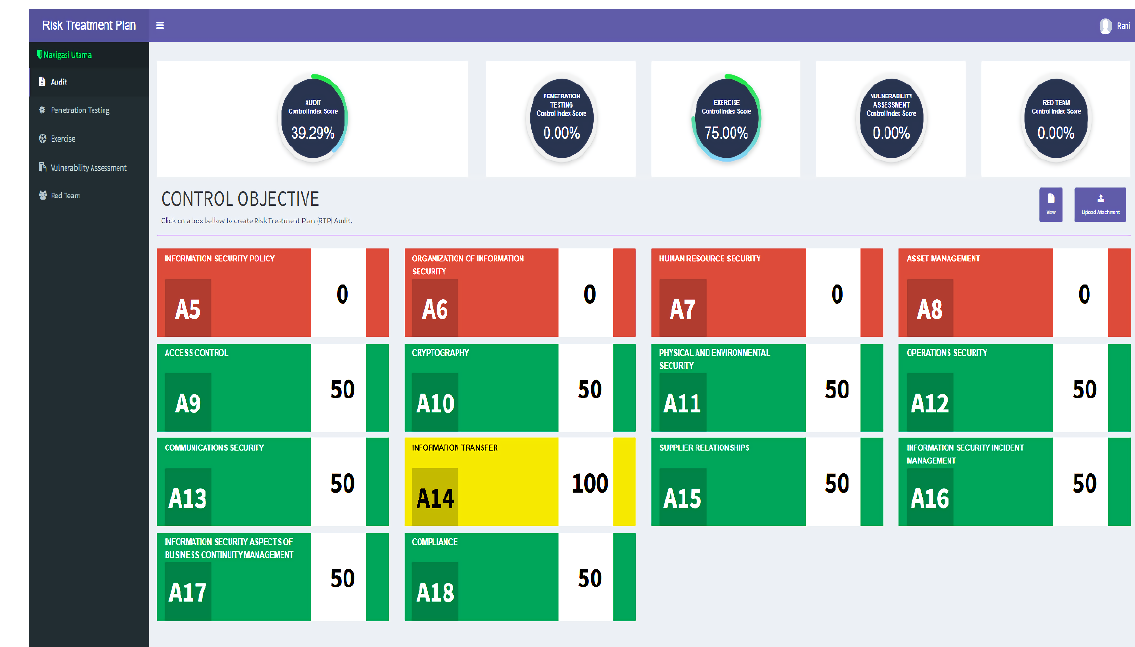
Figure 12. Visual Monitoring of Risk Control Treatment Plan of Audit Results.